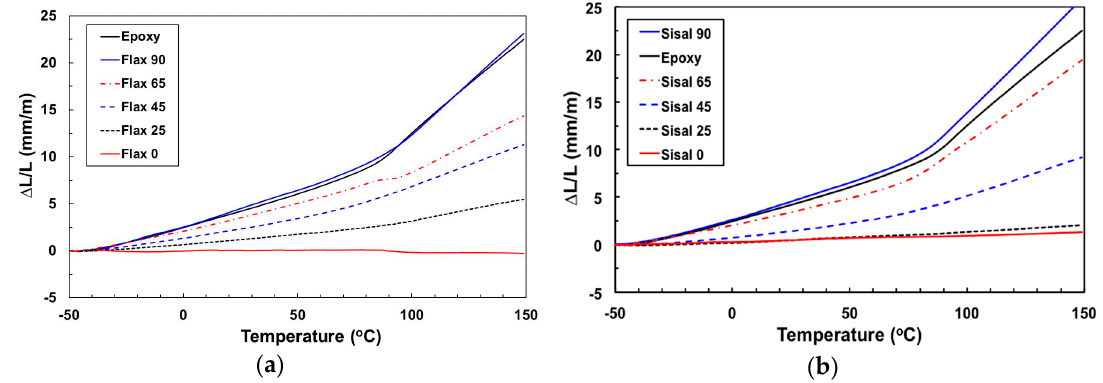
Figure 7. Results of TMA of epoxy matrix composites at various loading angles: ( a ) Flax fibre composites; ( b ) Sisal fibre composites.